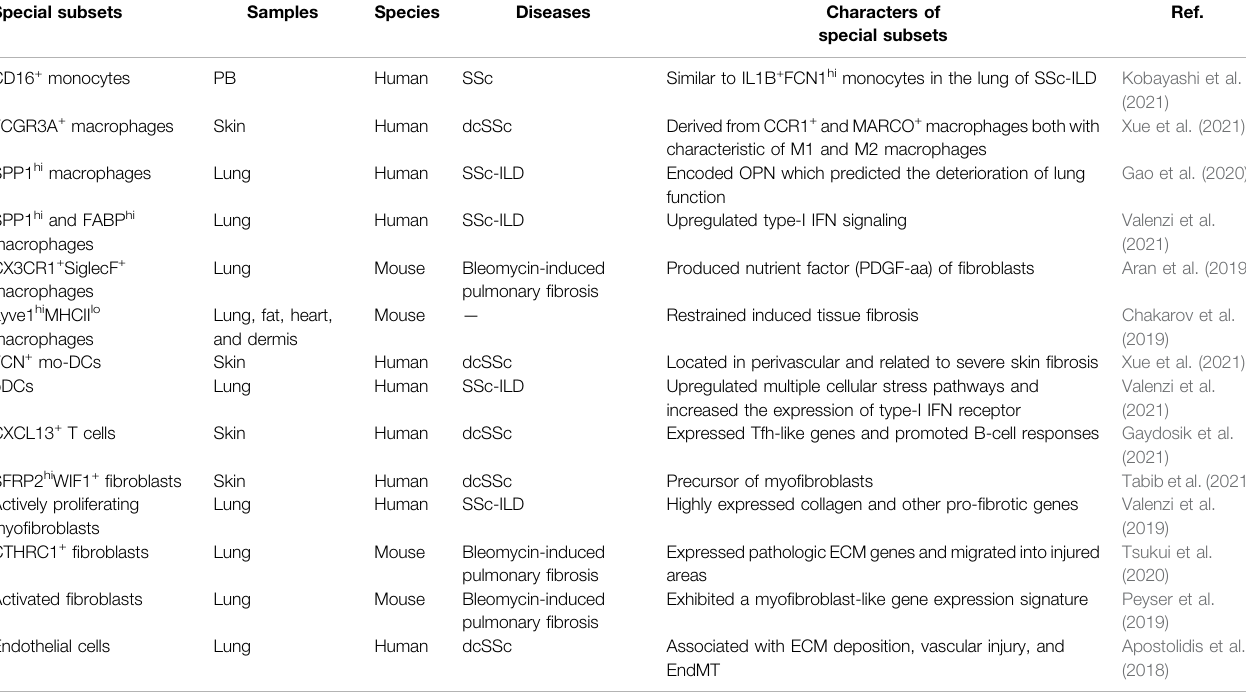
TABLE 1 | Immune cells and stroma cells in SSc by scRNA-seq. Special